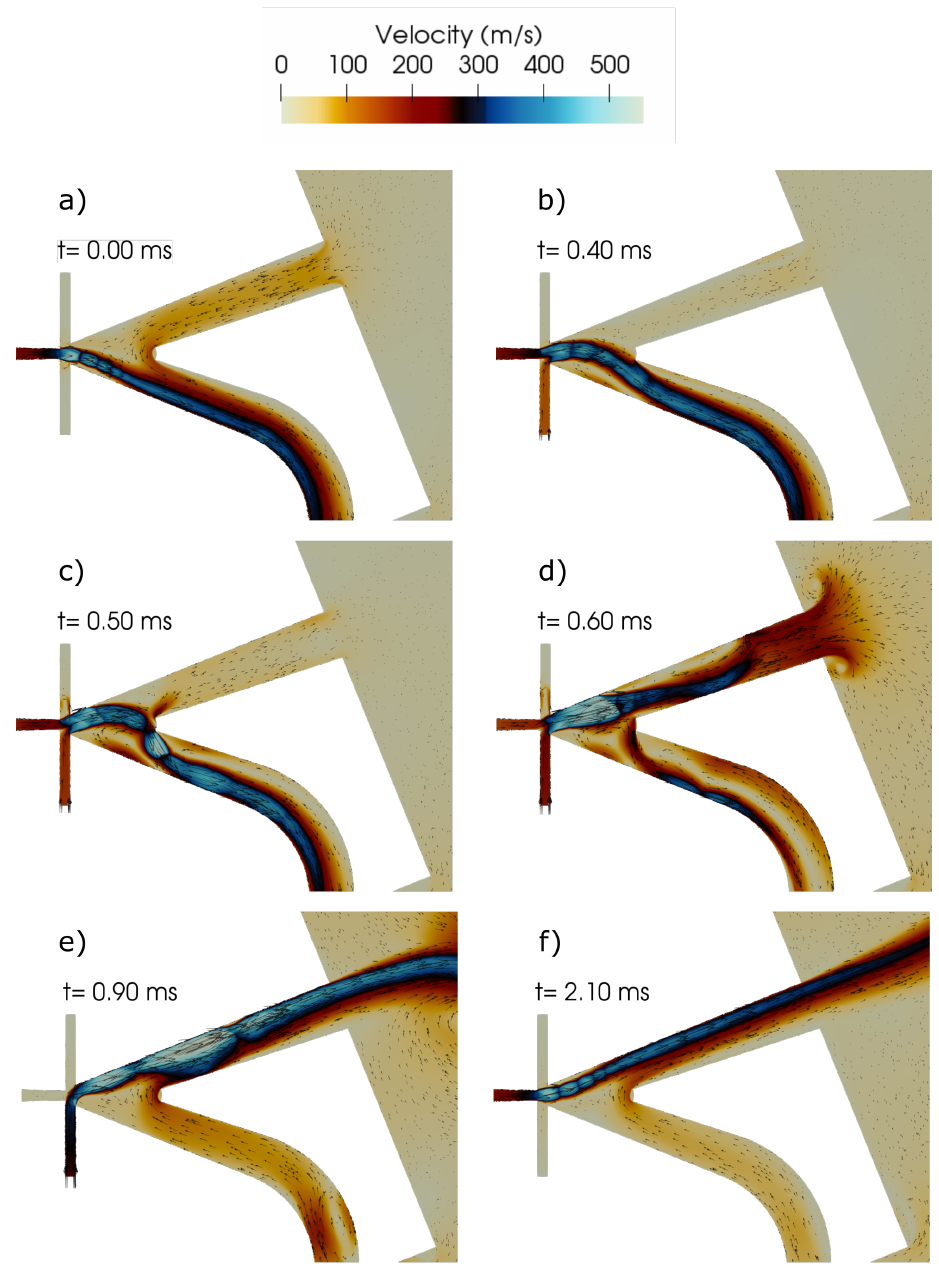
Figure 5. Supersonic simulation of the bistable fluidic amplifier ( a – f ): ( a ) stable condition lower output channel ( b ) increasing port flow (cid:42) growing recirculation bubble ( c ) main jet hitting the splitter structure, jet start to attach to the upper attachment wall ( d ) jet fully switched, dissipation of the recirculation bubble ( e ) stable condition upper channel with maximum control flow ( f ) stable condition upper channel without control